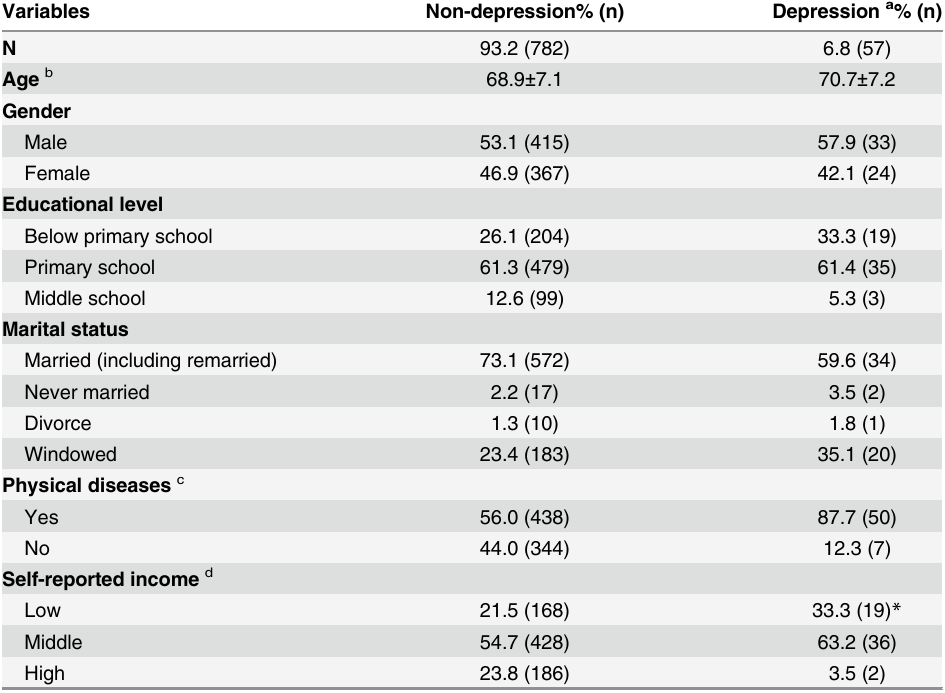
Table 1. Features of subjects ( N = 839).